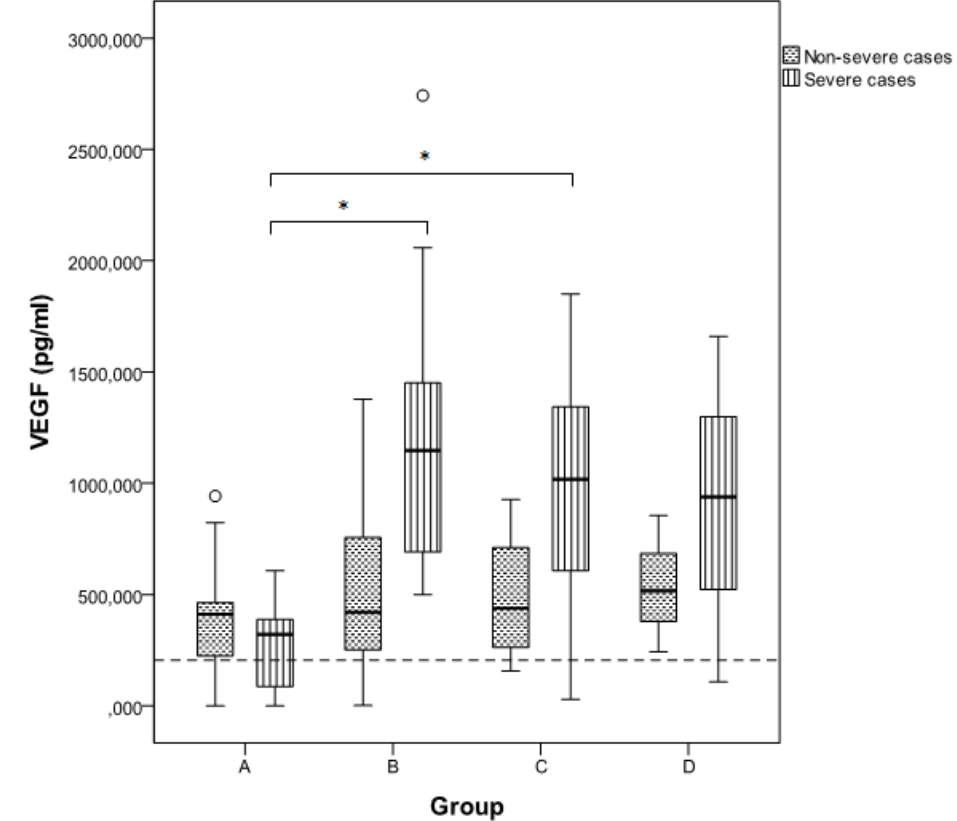
Figure 1. Comparison of VEGF levels between severe and non-severe cases in groups A–D. Data are given as median (thick line), 25th–75th percentile (box) and range (whiskers). Significant differences between groups ( p < 0.05) are shown with an asterisk. Group E is not shown, as only one sample was available from non-severe cases. The dotted line is set to 204.03 pg/mL and represents the mean VEGF value of the control